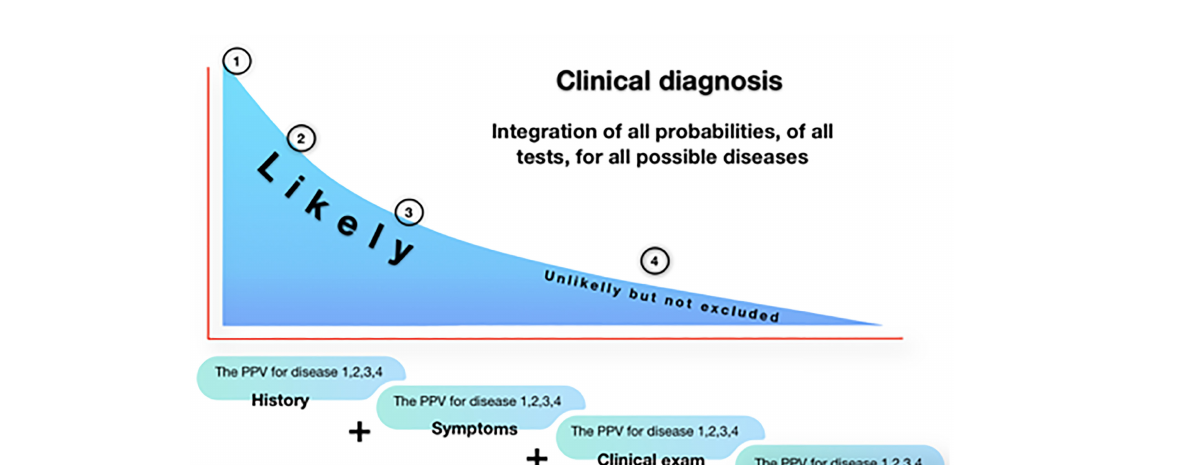
FIGURE 3 | Pain at distance.